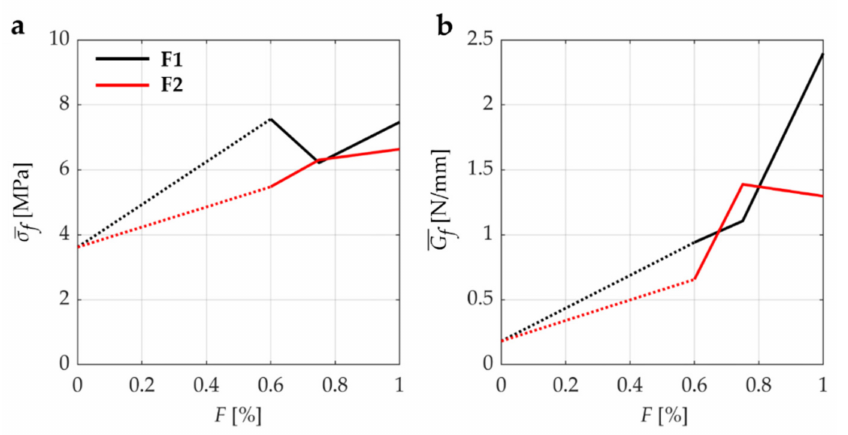
Figure 14. ( a ) Average bending strength σ f and ( b ) average fracture energy G f calculated in the 3PBT for the fibers, F1 and F2, and three different fiber contents, F